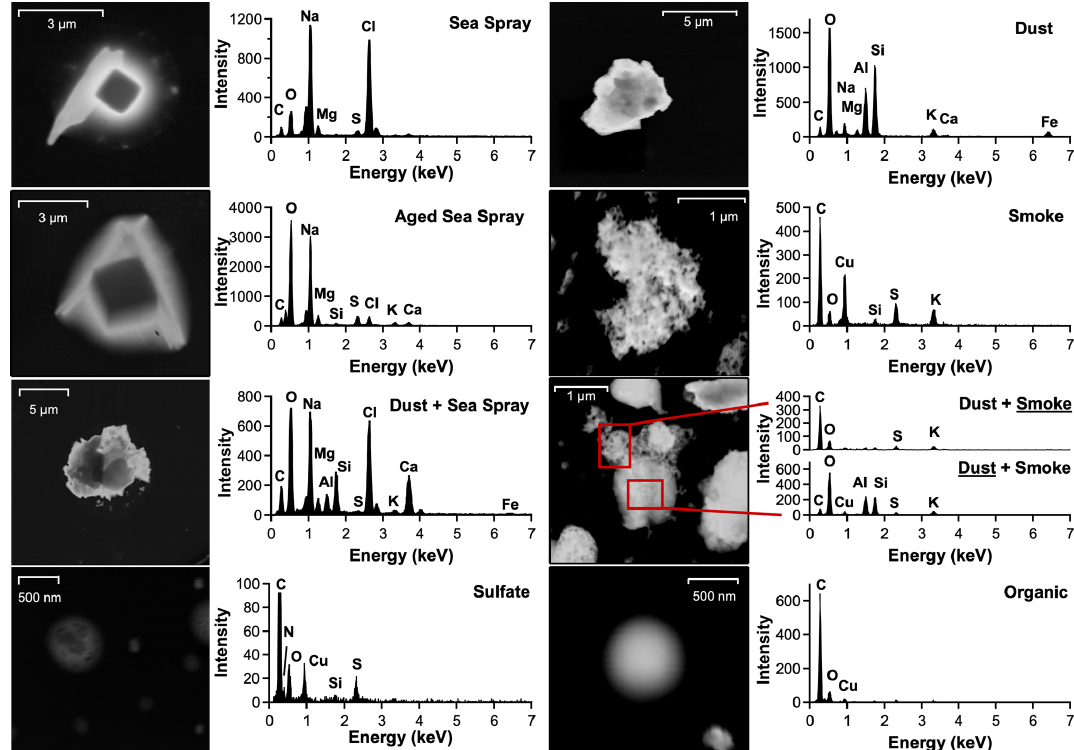
Figure 3. Characteristic aerosol particle types observed by SEM-EDX images (left) and spectra (right) in samples collected during the EUREC 4 A/ATOMIC campaign. Spectra for the dust + smoke particle type represent different areas analyzed on the particle with EDX, denoted by the red